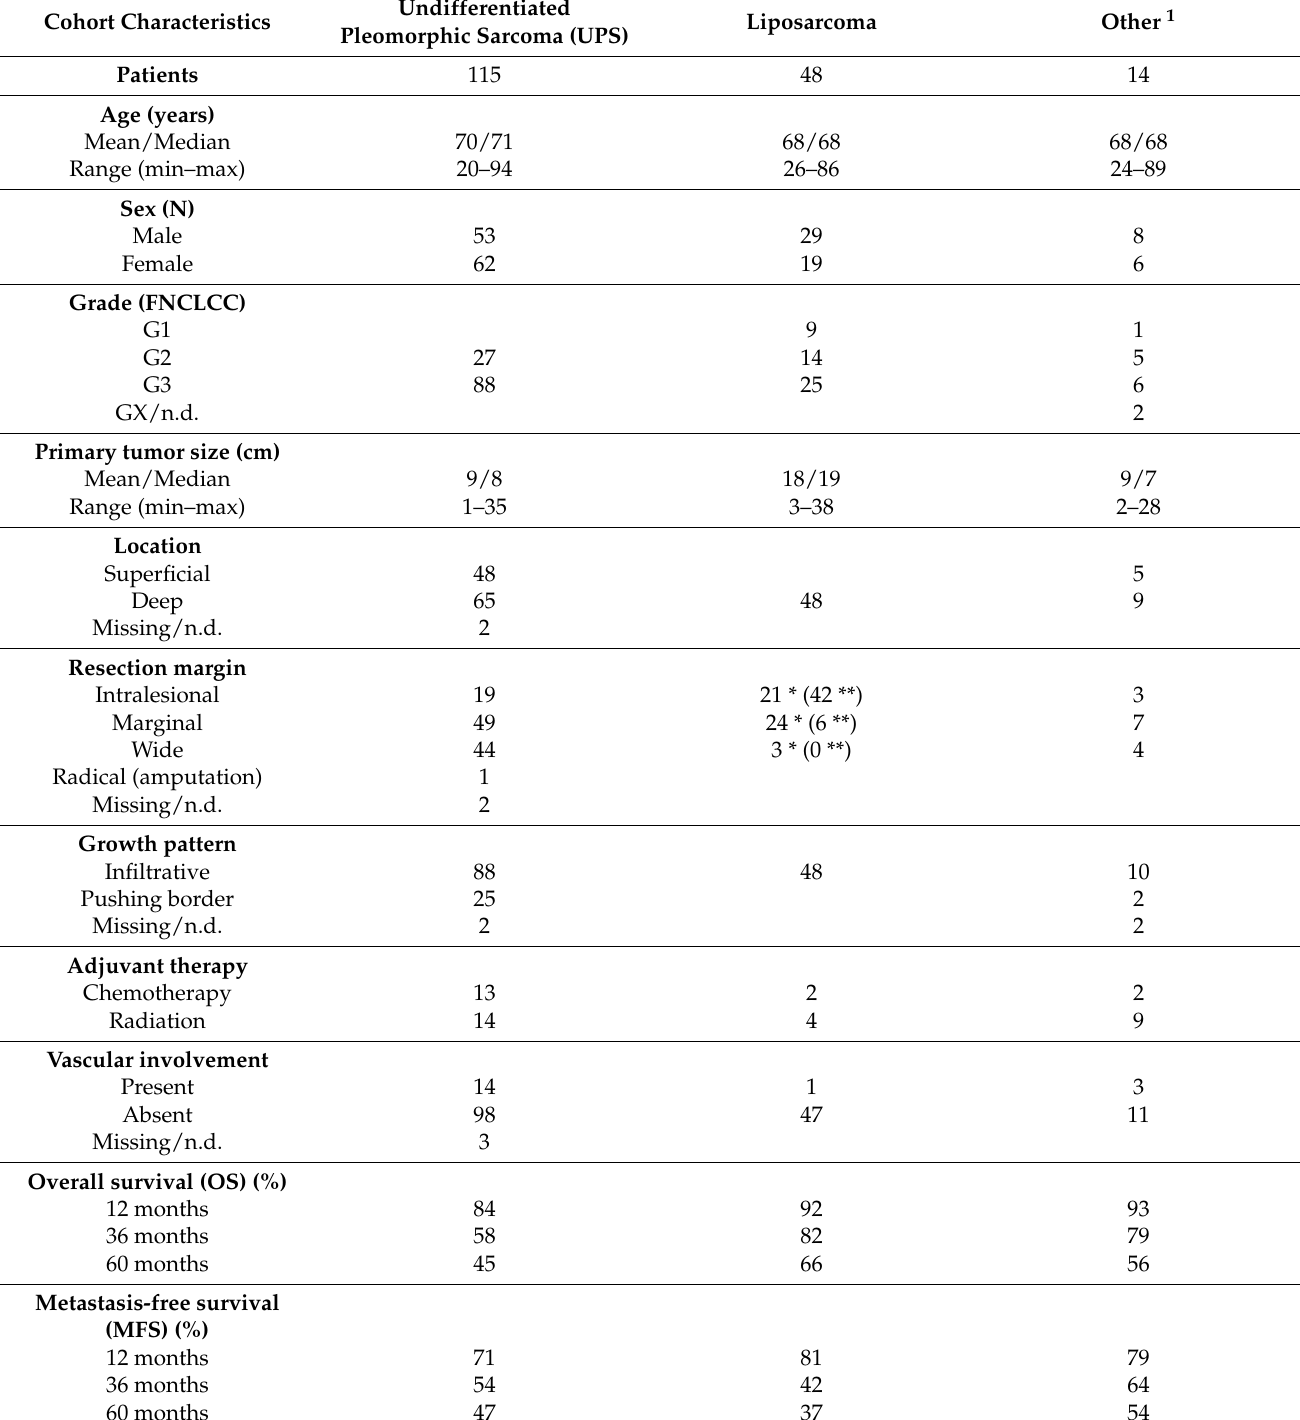
Table 1. Characteristics of the Karolinska soft tissue sarcoma (STS) cohort (inclusion years